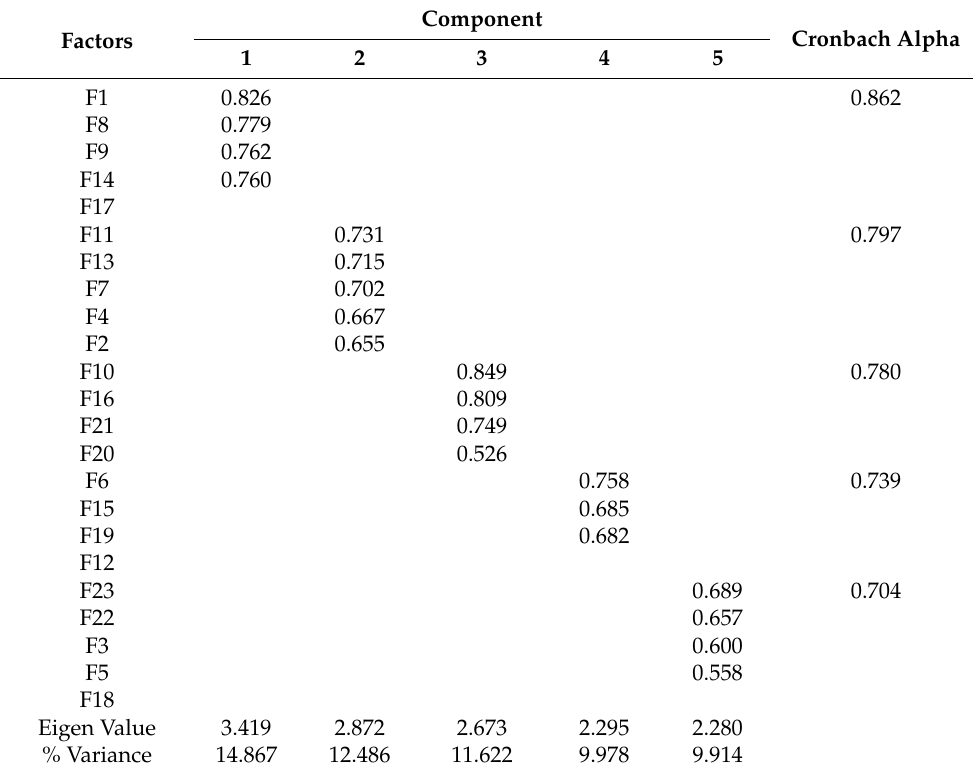
Table 3. Exploratory factor analysis result generated by busing SPSS 24.